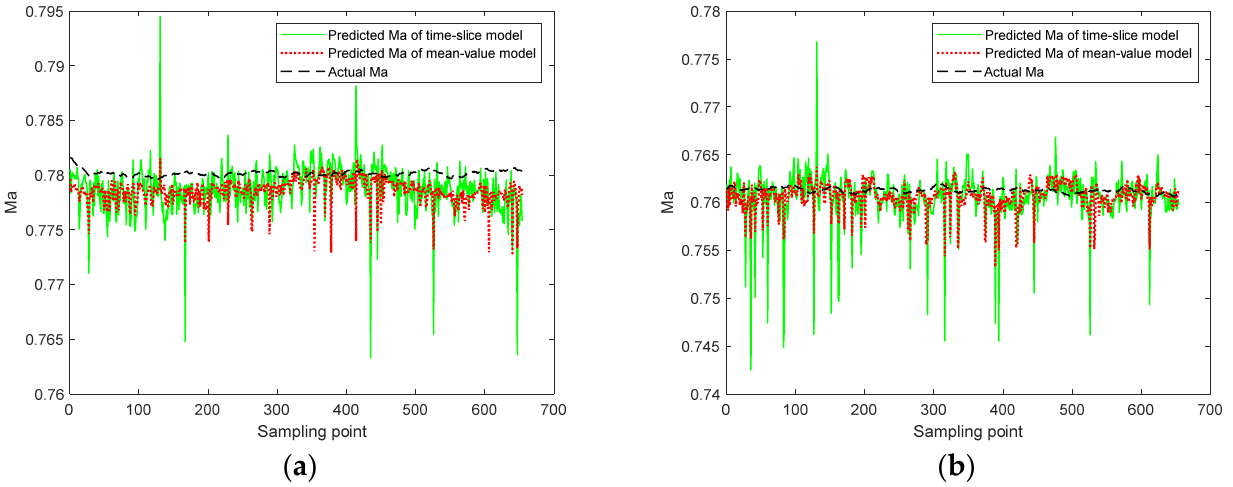
Figure 4. Multimode Mach number prediction results of the time-slice PLS and mean-value models. ( a ) Test data 1. ( b ) Test data 2.